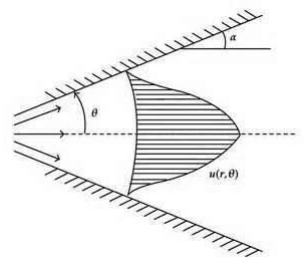
Figure 1. Geometry of the